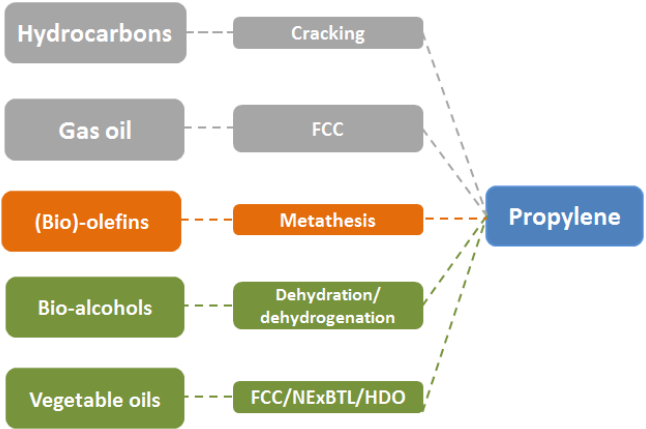
Figure 7. Schematic chart of C 3 H 6 production